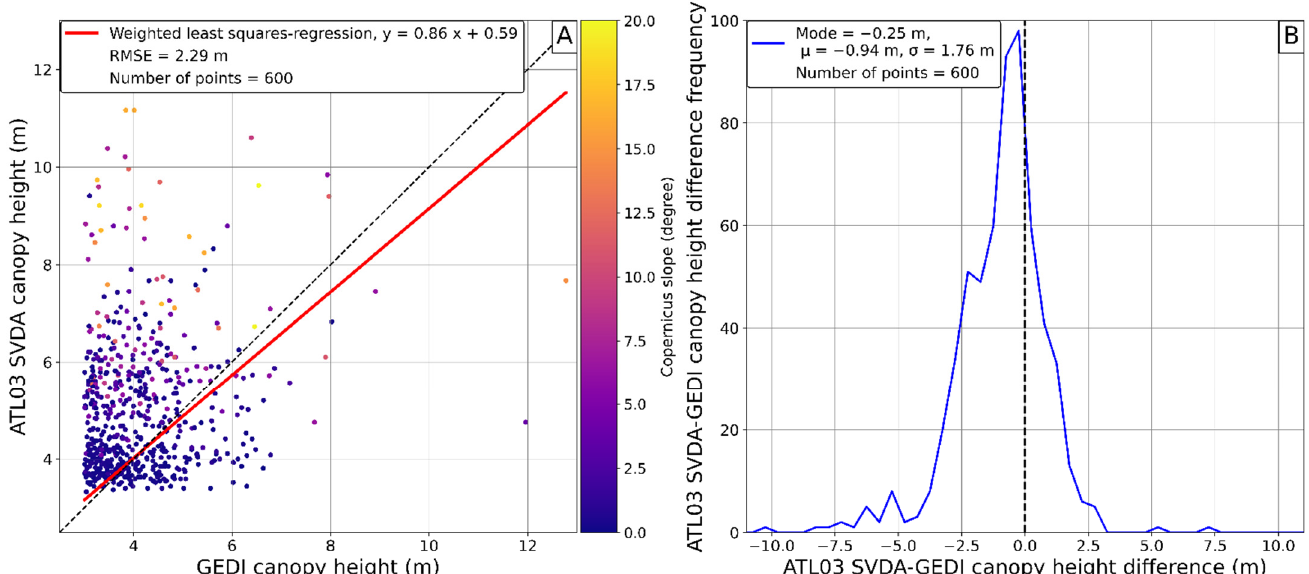
Figure 11. GEDI L2A version 2 and ATL03 SVDA canopy height relationship ( A ) and the distribution of ATL03 SVDA minus GEDI canopy heights ( B ). Comparison is based on 600 overlapping measurements within a buffer of 5 m and was carried out on the entire study area shown by the red polygon in Figures 1B,C and 2. GEDI canopy heights are generally lower than ATL03 SVDA canopy heights. Red line shows the weighted least squares regression, where the inverse of canopy height difference between ATL03 SVDA and GEDI measurements were used as weights.